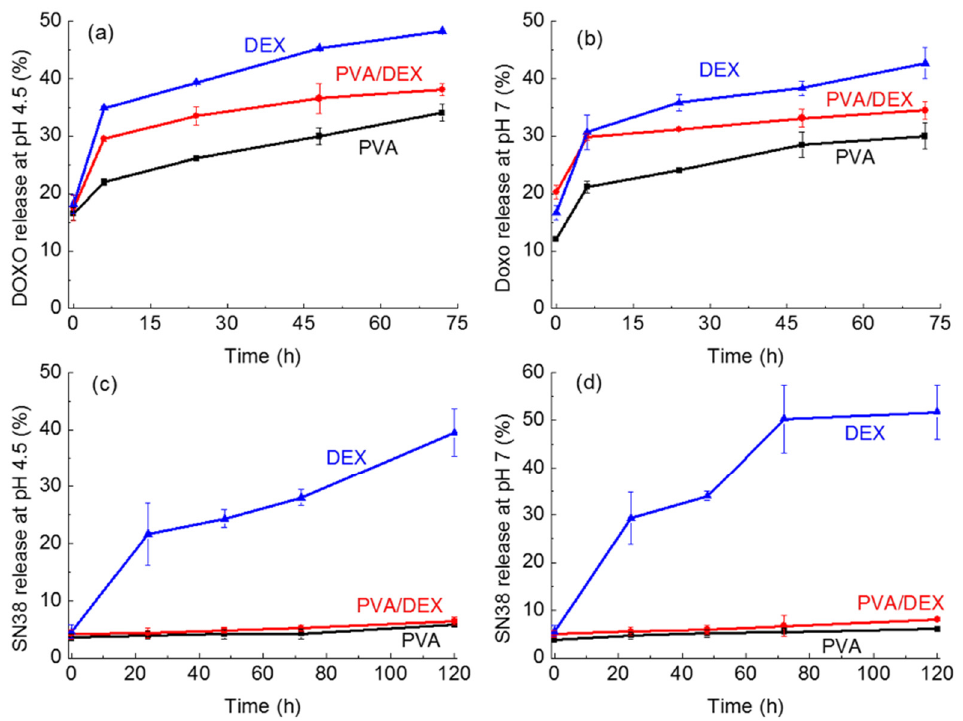
Figure 7. Release of the drugs from the NPs prepared with the different surfactants as a function of time. ( a ) DOXO at pH = 4.5; ( b ) DOXO at pH = 7; ( c ) SN-38 at pH = 4.5; (d) SN-38 at pH = 7.